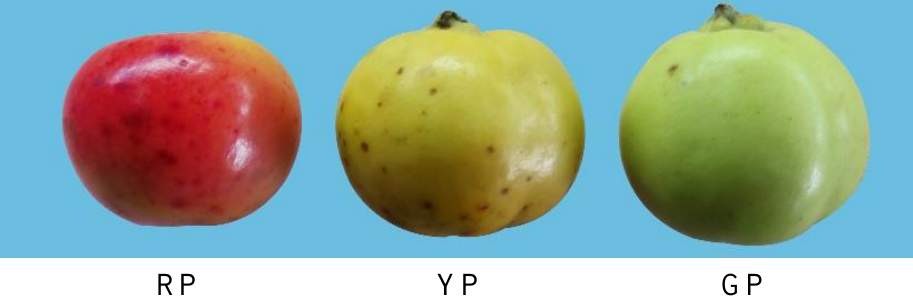
Figure 1. The different variations of D. delavayi : RP = red peel D. delavayi ; YP = yellow peel D. delavayi ; GP = green peel D. delavayi .